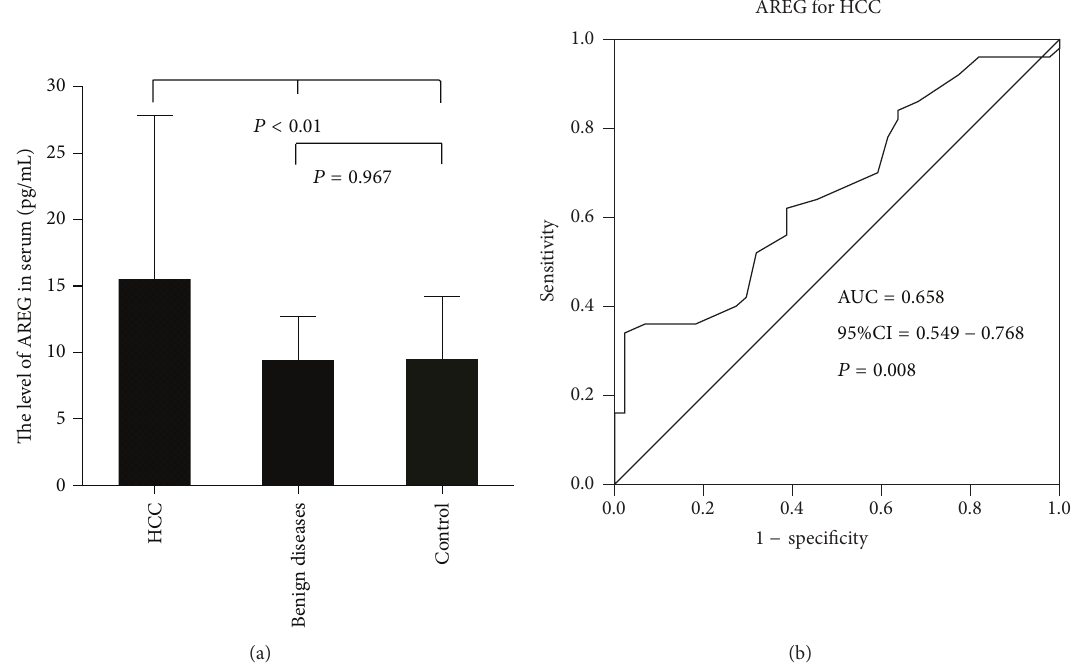
Figure 3: (a) showed the levels of serum AREG among normal controls, benign liver disease, and HCC patients. Mean levels of serum AREG and Std. Deviation is illustrated by bar charts; (b) showed the ROC curves of serum AREG between normal controls and HCC patients.